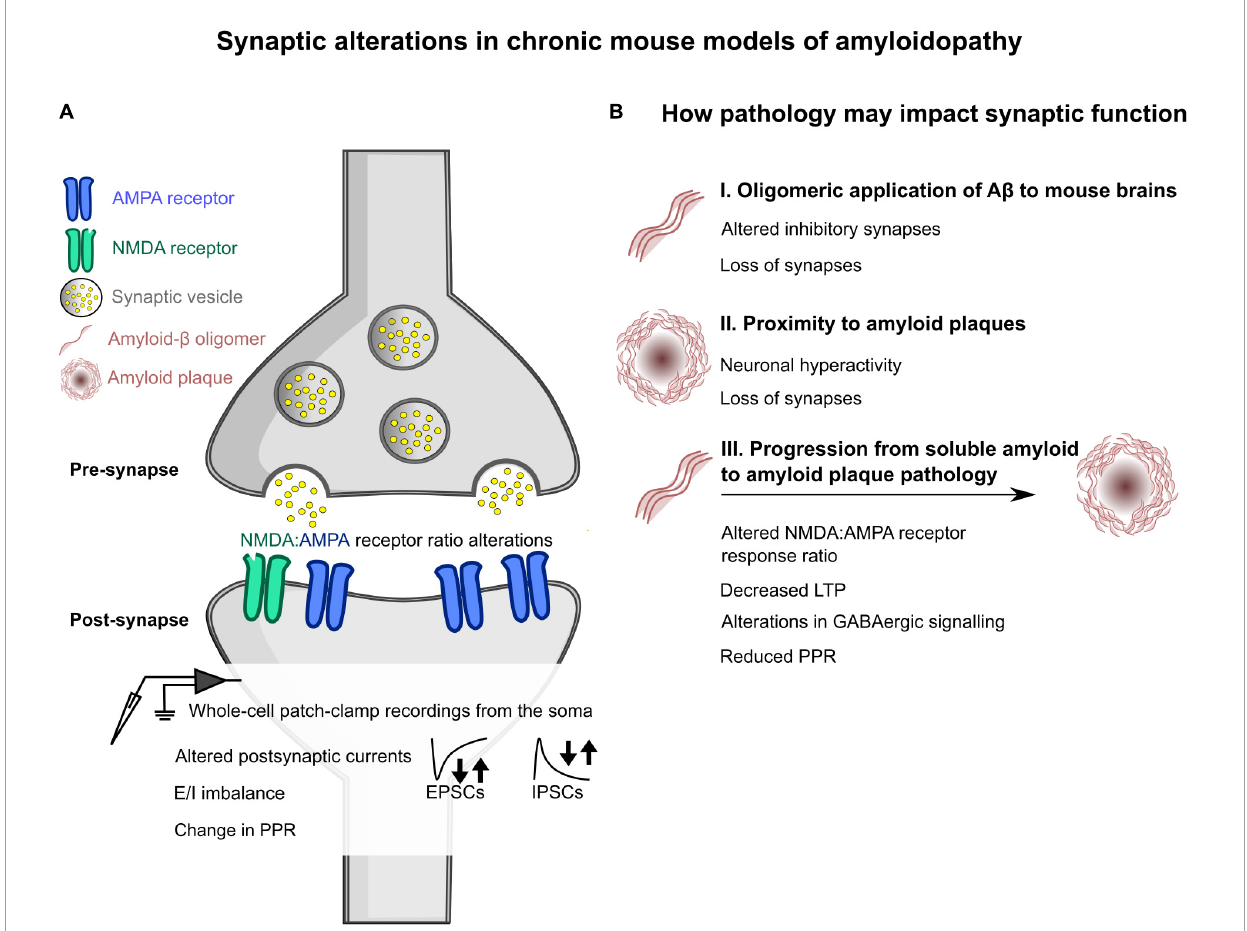
FIGURE1 Schematic overview of some of the changes induced by amyloidopathy at the synapse, as seen in chronic mouse models of amyloidopathy. (A) General changes in synaptic function at the pre- and post- synapse in chronic mouse models of amyloidopathy. Alterations at the post-synapse in amyloidopathy include a shift in the ratio between AMPA and NMDA receptors expressed at the post-synapse, measured using whole-cell patch-clamp electrophysiological recordings. Whole-cell patch-clamp recordings also showed either increases or decreases in the frequency of spontaneous and miniature excitatory post-synaptic currents (EPSCs) and inhibitory post-synaptic currents, denoted by arrows. The ratio of these two currents (E/I balance) was also skewed in some mouse models. There were also changes in the paired-pulse ratio (PPR), with either increased or decreased ratios measured. (B) An outline of how amyloid pathology can impact synaptic function. (B I) Changes observed when oligomeric amyloid- β is applied to the brains of mice by microinjection or by topical application to brain slices. This includes altered inhibitory synapses and an overall loss of synapses. (B II) How distance to amyloid plaques may alter synapses within chronic mouse models of amyloidopathy. Two phenomena that have been observed are increases in neuronal hyperexcitability when in close proximity to plaques, and an overall loss of synapses as well. (B III) How different phenotypes emerge with the progression of pathology in chronic mouse models of amyloidopathy. These experiments investigated changes with age in mouse models that will progressively develop amyloid plaque pathology. Some alterations that were observed at older ages, where plaque pathology is present, included a change in NMDA:AMPA receptor ratio as determined by whole-cell patch-clamp electrophysiology, decreased long term plasticity (LTP), changes in GABAergic signaling, and reduced